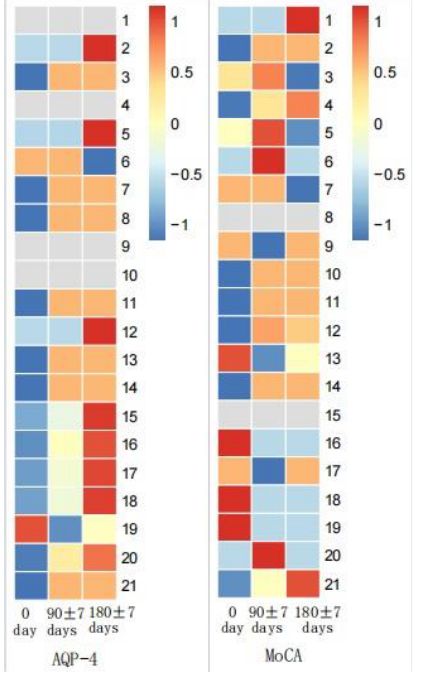
Figure 5. MoCA scores and AQP-4 antibody titers in NMOSD during follow-up. Table 5. MoCA scores and AQP-4 antibody titers in NMOSD during follow-up. F p AQP-4 antibody titer (the second time)